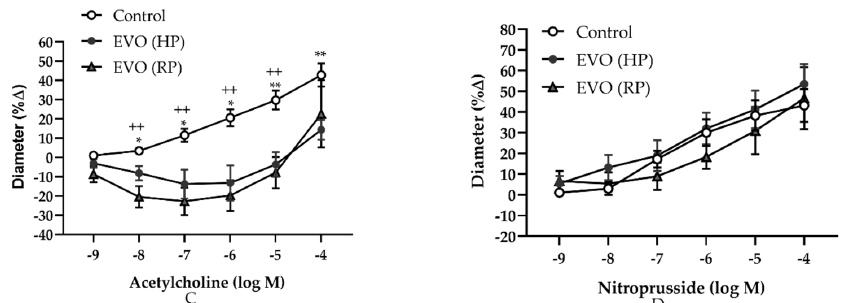
Figure 2. Relative changes in the luminal dimeters of retinal arterioles in response to different intravascular pressures and vasoactive agents. The changes in response to stepwise increases in intraluminal pressure ( A ), to the thromboxane mimetic, U46619 ( B ), to the endothelium-dependent vasodilator, acetylcholine, ( C ) and to the endothelium-independent vasodilator, nitroprusside ( D ). EVO: episcleral vein occlusion; HP: high intraocular pressure; RP: recovered intraocular pressure. Control group refers to the sham group. Values are expressed as mean ± SEM (* p < 0.05, ** p < 0.01, Control vs. EVO (HP); ++ p < 0.01, +++ p < 0.001, ++++ p < 0.0001, Control vs. EVO (RP); n = 8 per group).